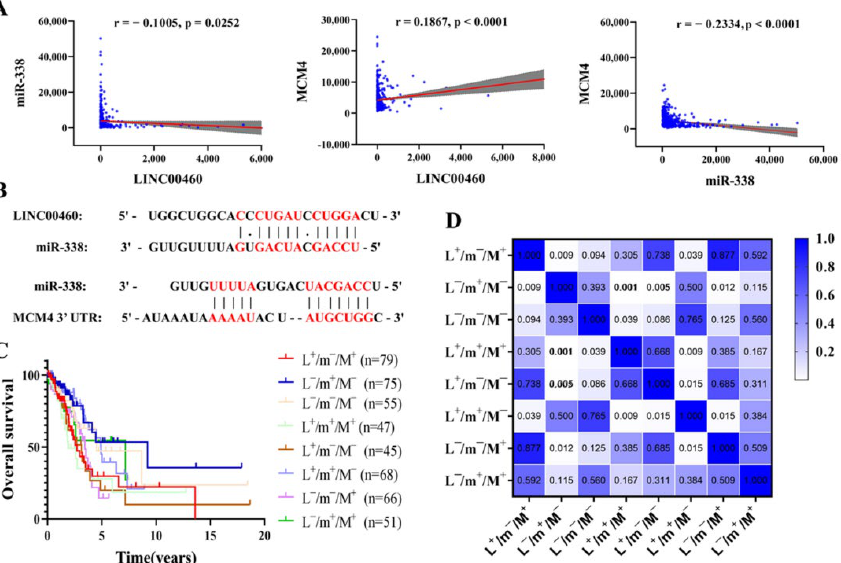
Figure 5. Target site prediction and expression correlation analysis among LINC00460, mir-338-3p and MCM4. ( A ) Correlation analysis between LINC00460, mir-338-3p and MCM4 in LUAD ( n = 515). Grey shaded areas indicate 95% confidence intervals. ( B ) Base pairing between mir-338-3p and the target site in the LINC00460 and MCM4 3′ UTR. Correlation analysis of different expression patterns of LINC00460—mir-338-3p—MCM4 with OS of LUAD patients ( C ), with heat map of significance of differences ( D ). A p < 0.05 was considered statistically